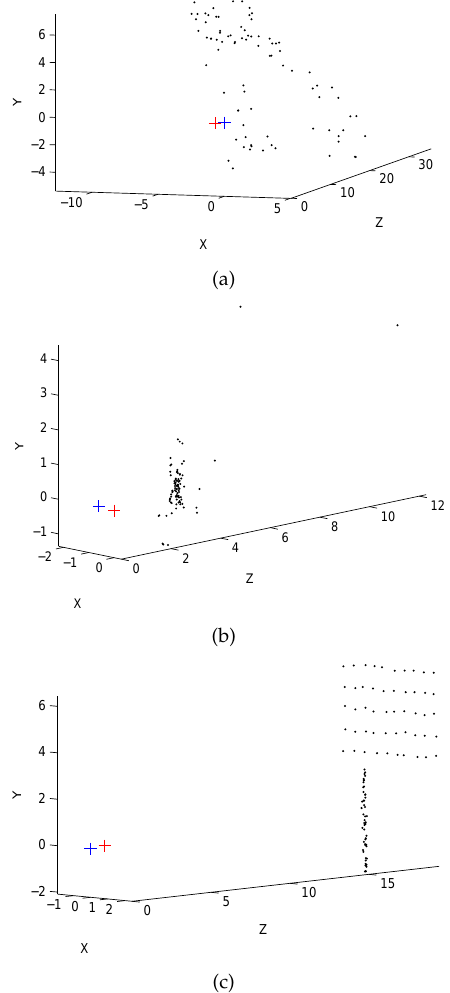
Figure 5. 3D metric reconstruction result with ours metric gold criterion for ( a ) Dino , ( b ) Zhanglan and ( c ) Simu . The red and blue ’ + ’ are the positions of two cameras. In ( c ), we rotate the scene to a special view point to see that the 50 points lie at a same plane and thus nearly only a line can be seen at the lower part of the figure, which validate that our method is reasonable and robust. The precision analysis is described in the last paragraph of Section